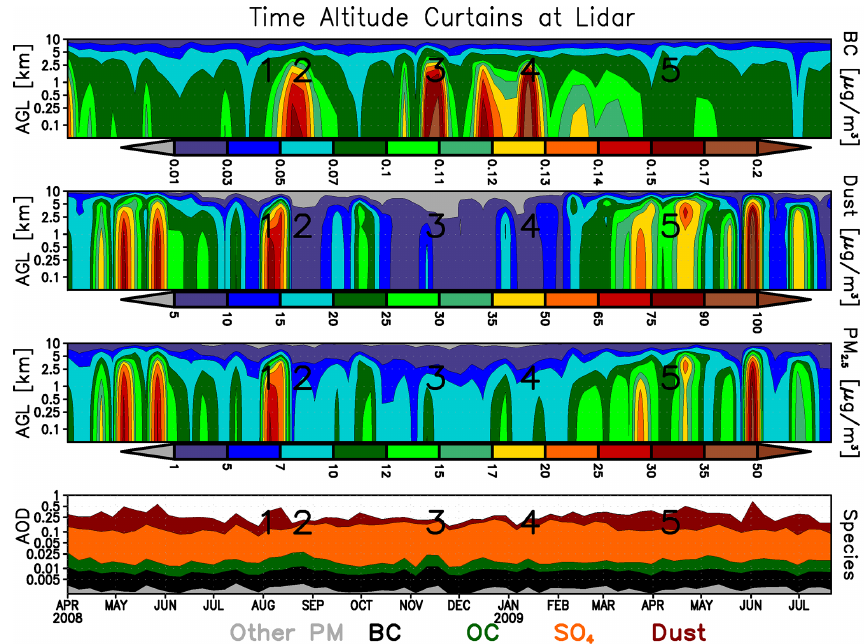
Figure 13. Time–altitude cross sections of weekly averaged predicted BC, dust, and PM 2 . 5 for the simulation period at the LST site. The numbers denote the specific episodes of aerosol enhancements for back trajectory analysis in Figs. 14 and 15. “Lidar” denotes the LST